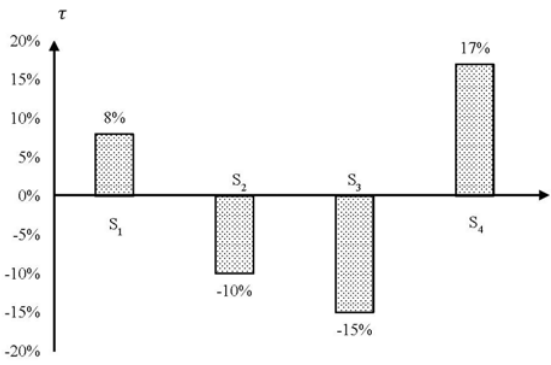
Figure 8. Level of efforts sufficiency.